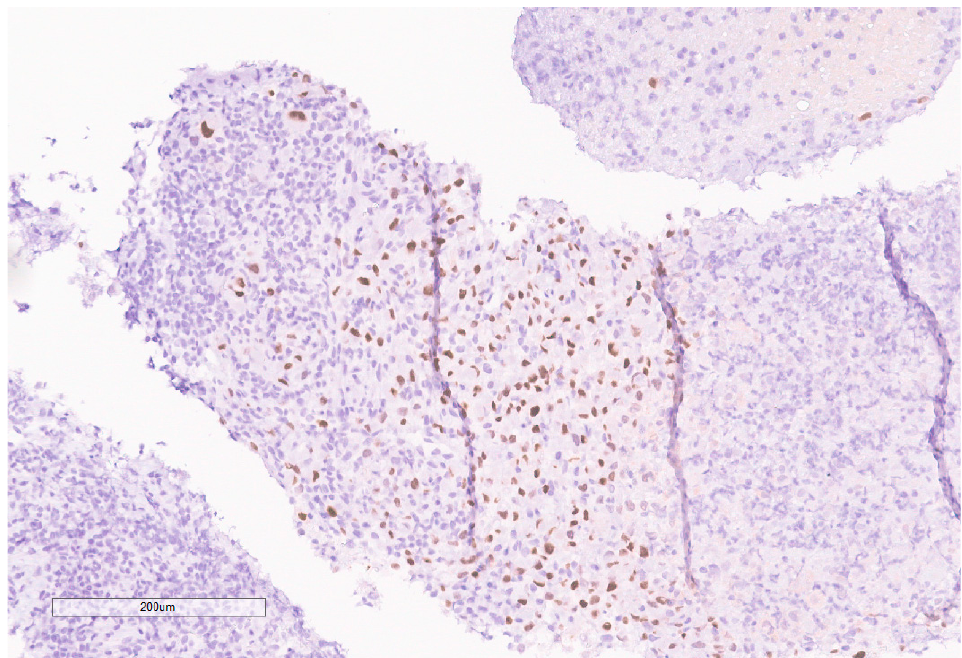
Figure 8. Pancytokeratin stain is positive in the tumor.